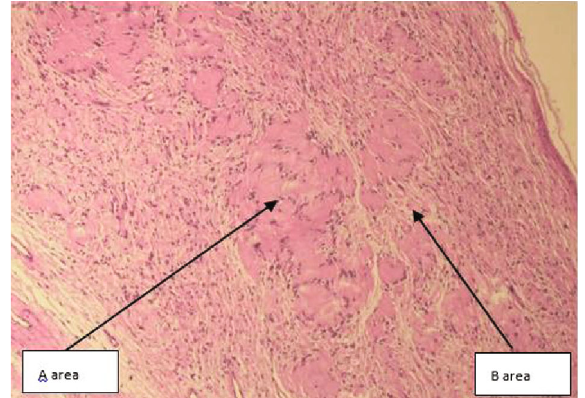
Figure 7: Histopathological examination. The lesion is composed of spindled cells with hypercellular Antoni A areas and hypocellular Antoni B areas.